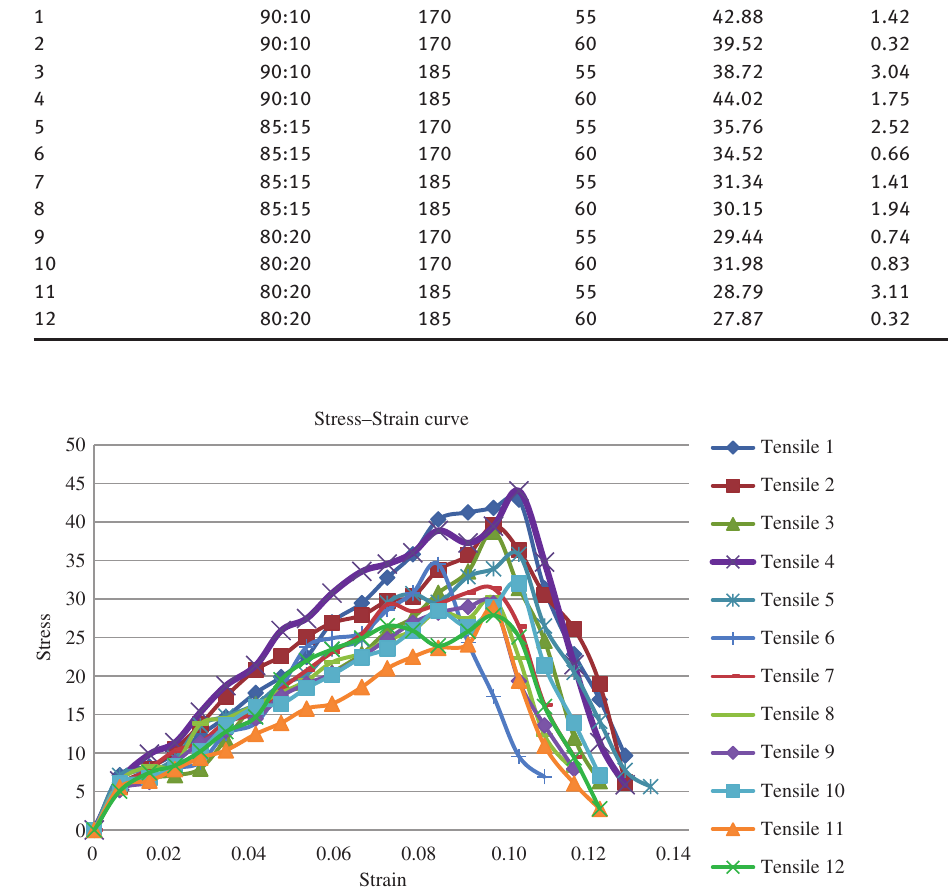
Figure 2: Stress-strain curve of HA-PLA